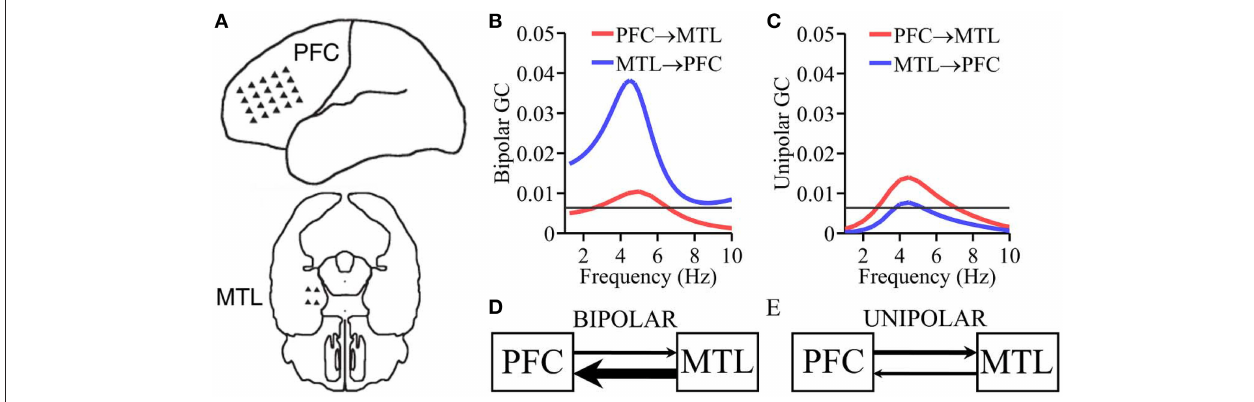
FIGURE 4 | ECoG recording from epilepsy patient. (A) Placement of electrode arrays. (B) Granger causality spectra using bipolar data. (C) Granger causality spectra using unipolar data. (D,E) Schematic summarizing the Granger causality results where the thickness of the arrows is proportional to the corresponding Granger causality